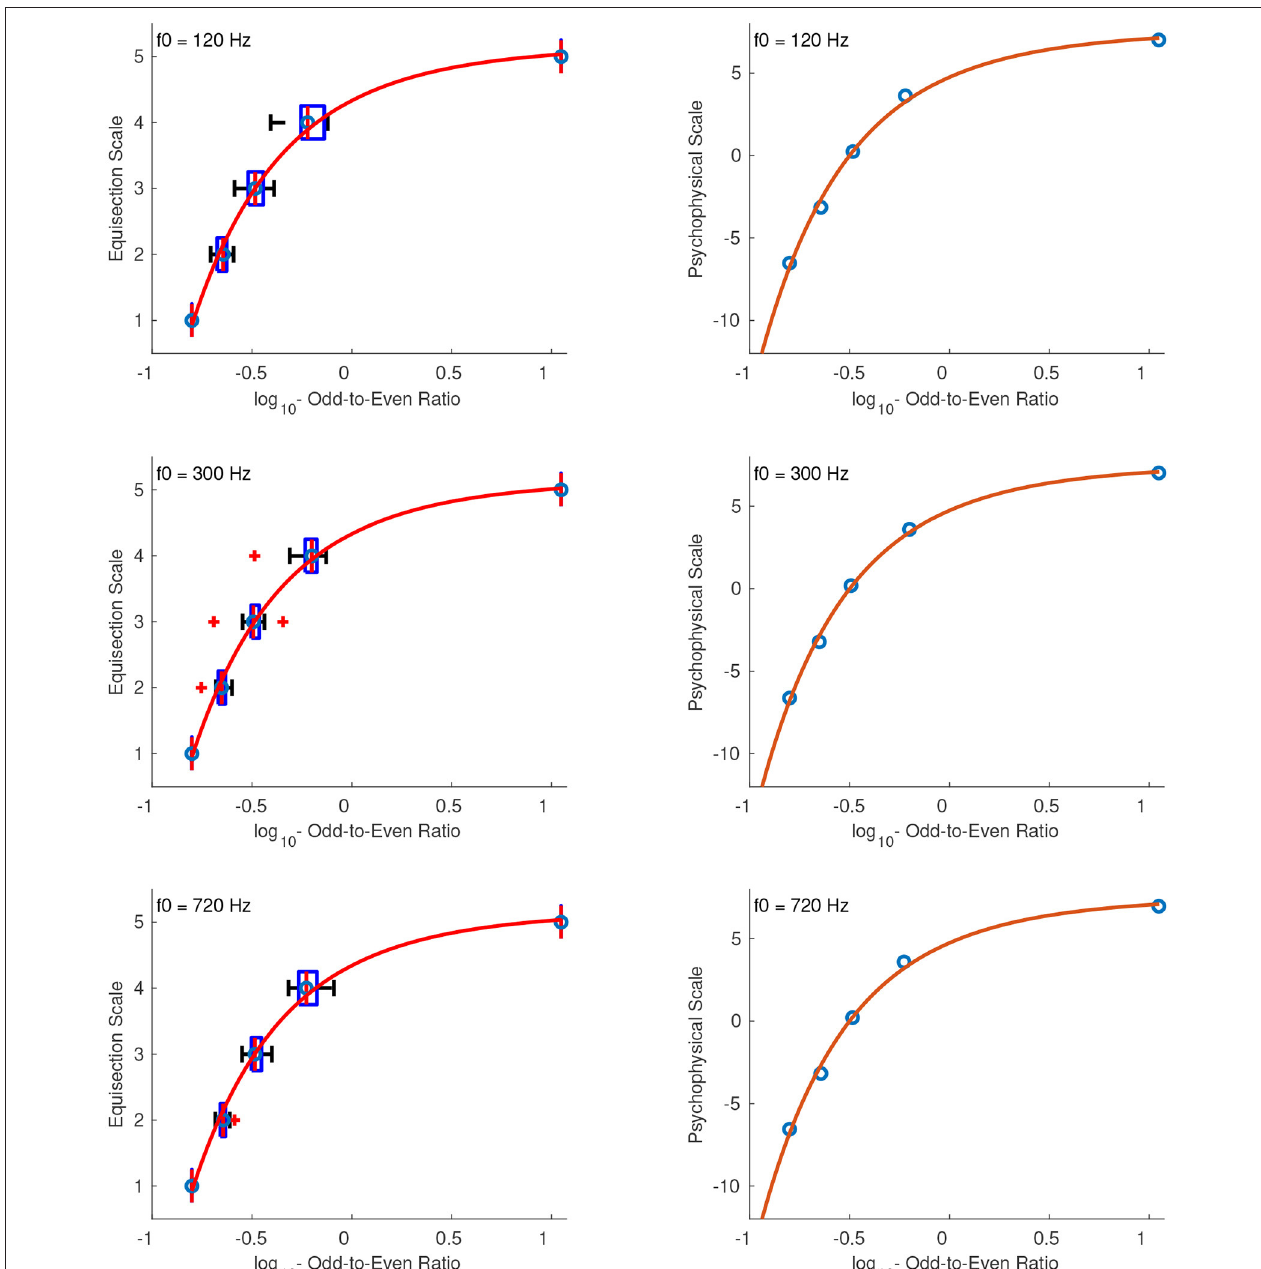
FIGURE 12 | Equisection and psychophysical scales of odd-to-even ratio at three f0s. Left panel, Boxplots and fitting function on the median ratings. Whiskers extend to 2.7 SD; Right panel, psychophysical scale and extrapolated fitting function on log 10 -transformed stimulus values.